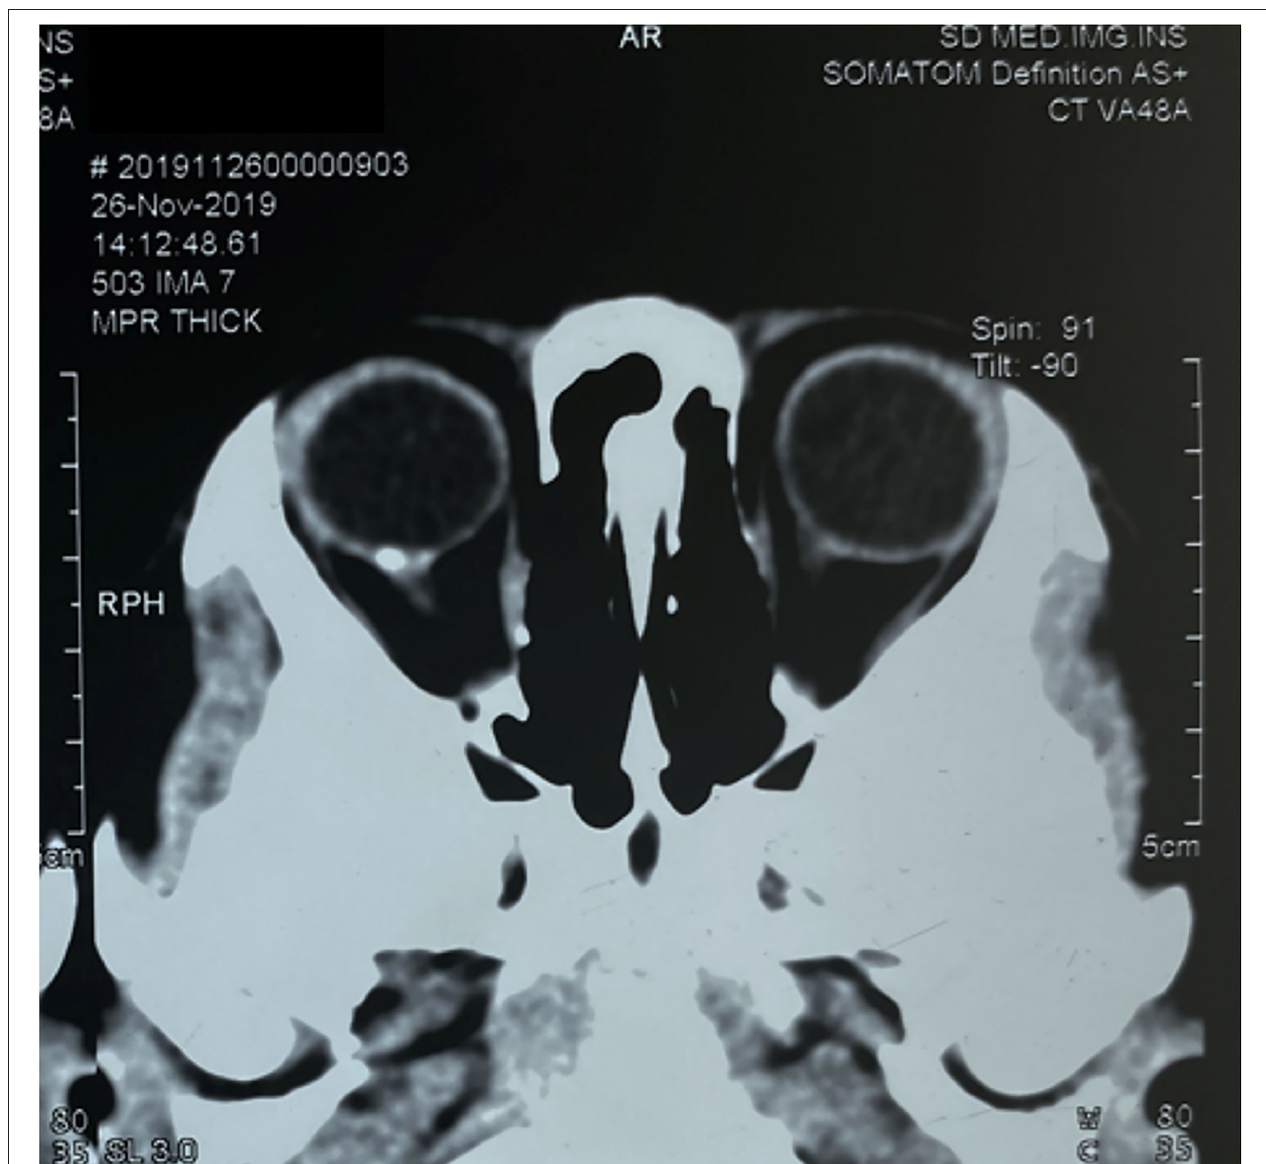
FIGURE 2 | Computerized tomography scan of the orbit demonstrated a hyperdense choroidal plaque with the same density as bone at the level of the optic disc in the right